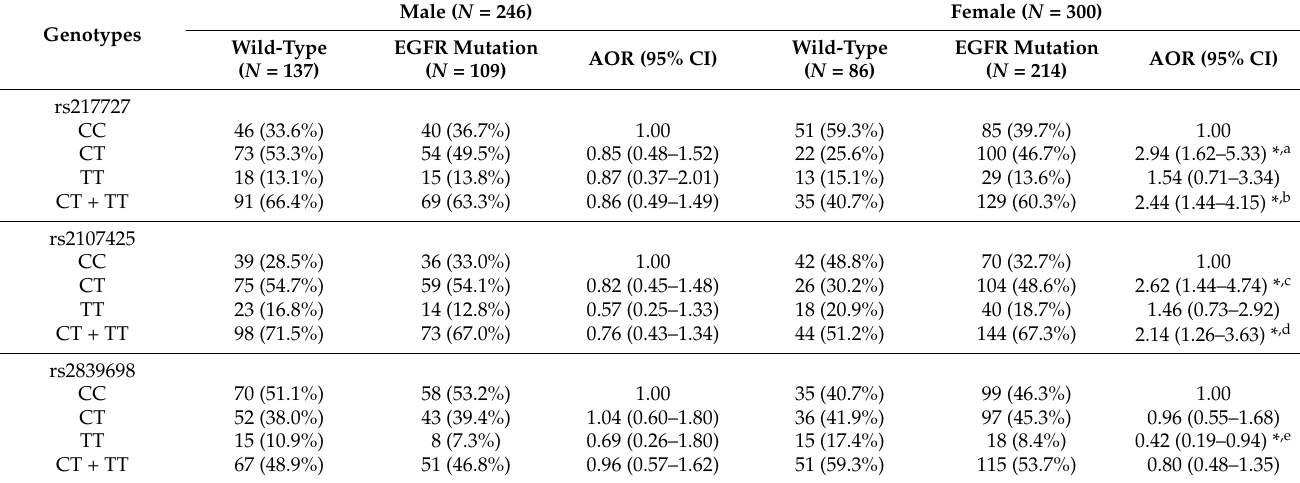
Table 3. Distribution frequency of H19 genotypes of 300 female patients with lung adenocarcinoma and multiple logistic regression analysis of EGFR mutation